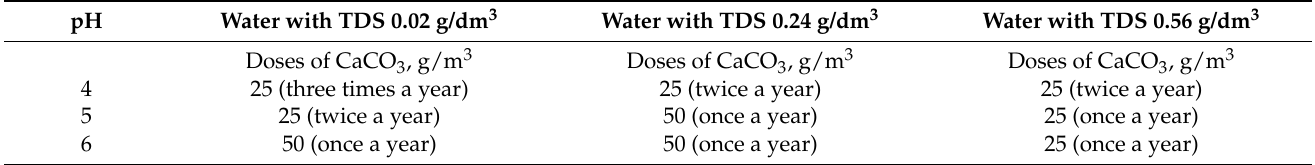
Table 2. Recommended doses of dispersed, thermally activated limestone in surface water.